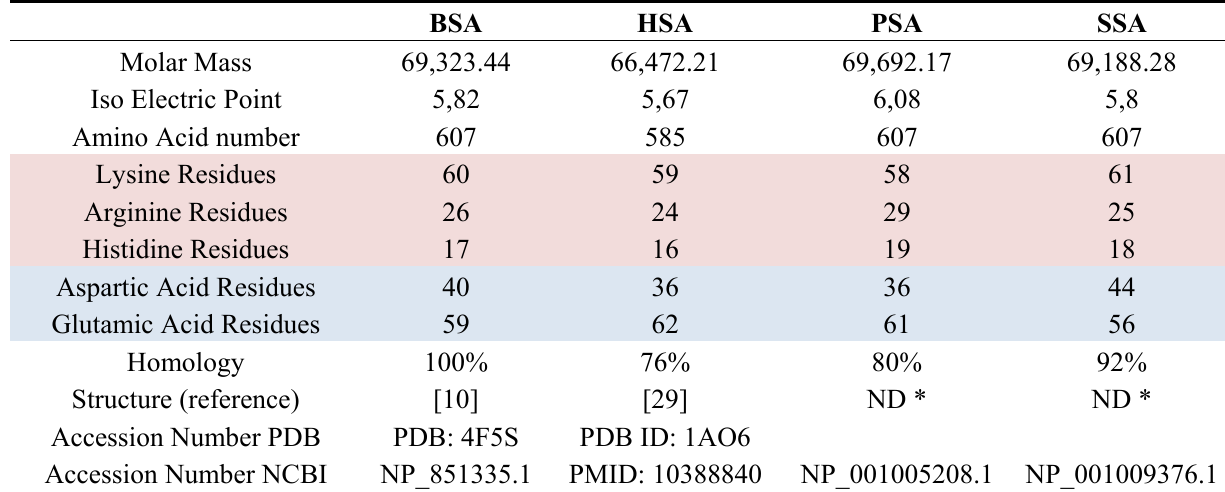
Table 1. Physical molecular data of different albumin